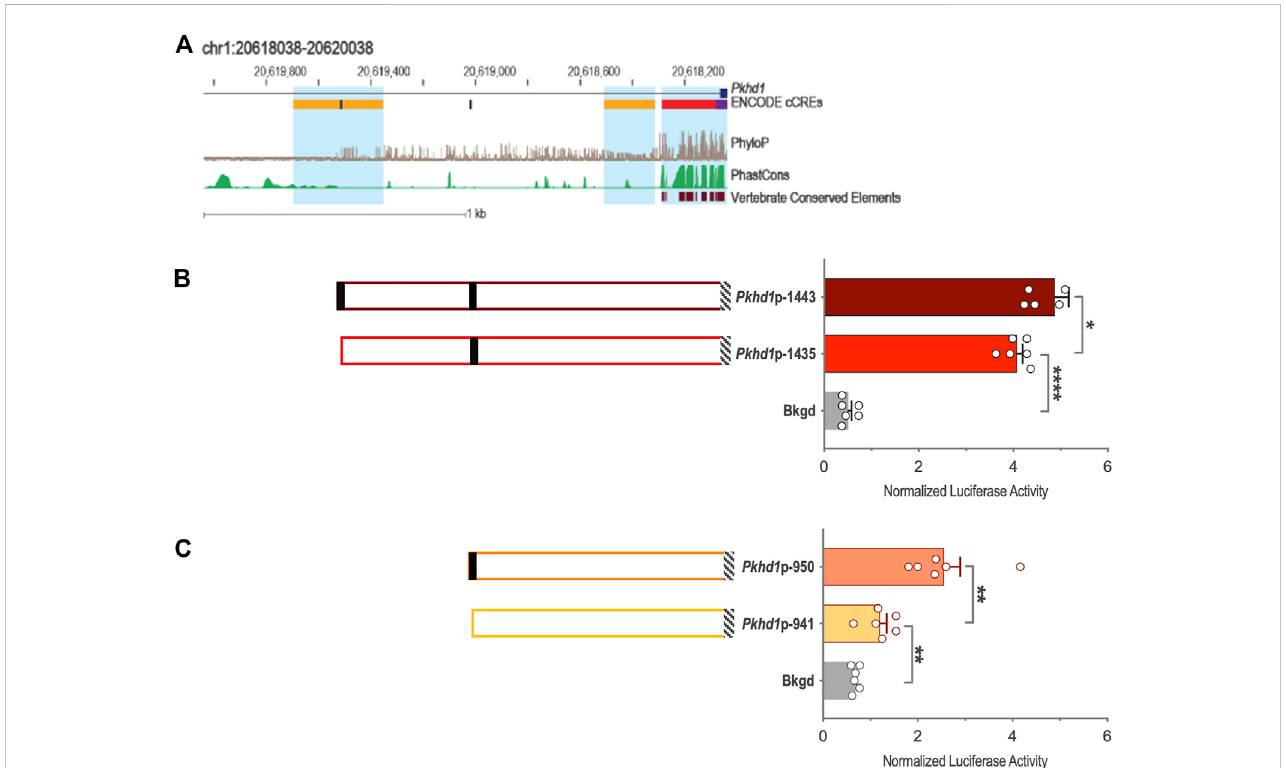
FIGURE 3 Pkhd1 upstream regulatory region and reporter gene analysis of the Pkhd1 promoter constructs. (A) Map of the Pkhd1 upstream regulatory region showing UCSC tracks for predicted regulatory elements (cCRE and Vertebrate Conserved Elements) and sequence conservation (phyloP and PhastCOns). Black rectangles indicate TFAP2B binding sites. (B and C) Pkhd1 promoter constructs and corresponding normalized luciferase activities in transfected mIMCD-3 cells. Black rectangles indicate TFAP2B binding sites. Hatched boxes indicate Pkhd1 promoter and 5 ′ -UTR sequences. The error bar indicates S.E.M.; * indicates p < .05; ** indicates p < .01.